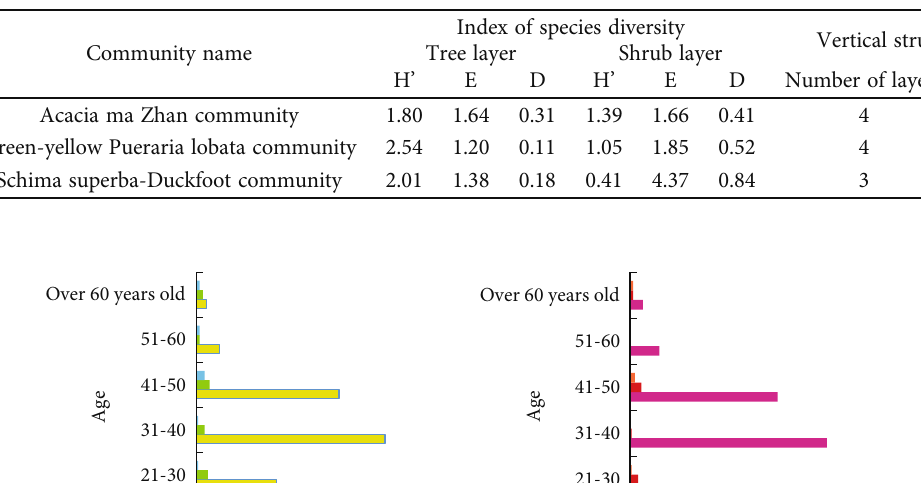
Table 5: Species diversity and vertical structure of plant communities in three forests.